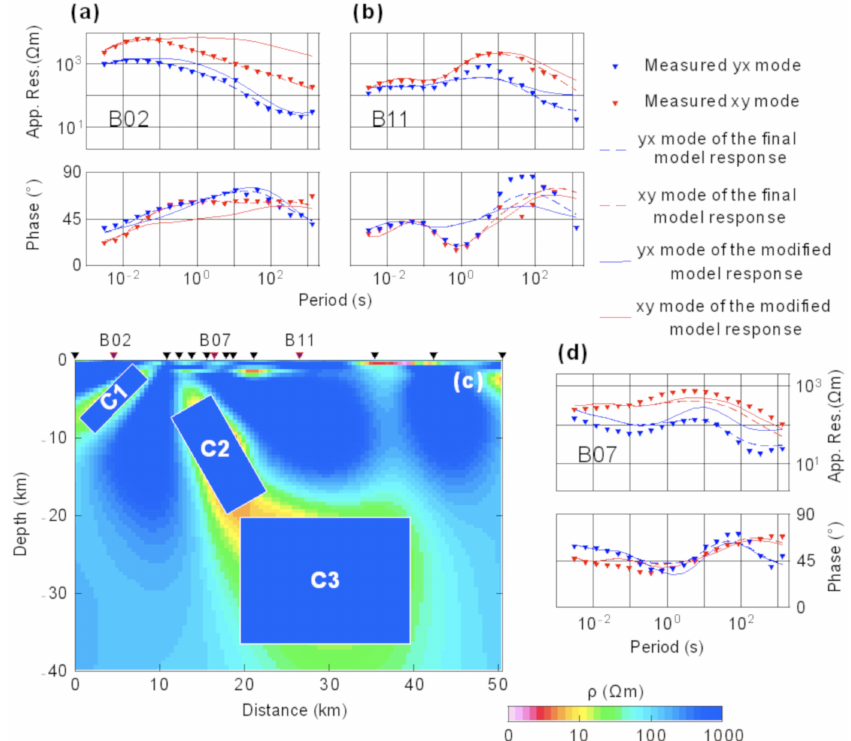
Figure 10. The revised model for the sensitivity test ( c ), and the results of sensitivity test ( a , b , d ). The triangles denote the measured MT data, the dashed lines denote calculated data from the final model, and the solid lines indicate calculated data from the revised model. The MT sites are shown as red solid triangles on the top of the revised